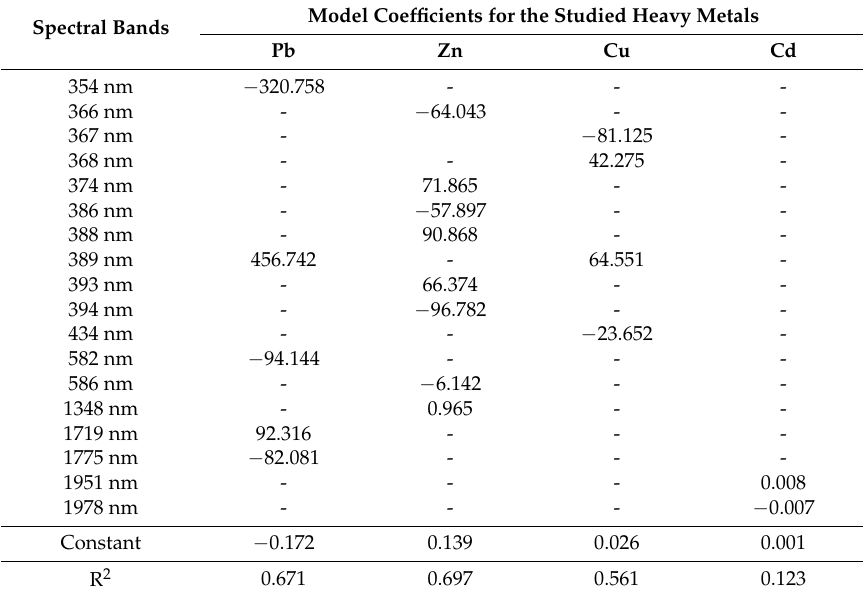
Table 2. Summary of the selected spectral bands and regression coefficients for the field-based spectral library using stepwise multiple linear regression. A dash denotes that the spectral band was not included in the model equation for the relevant heavy metal.